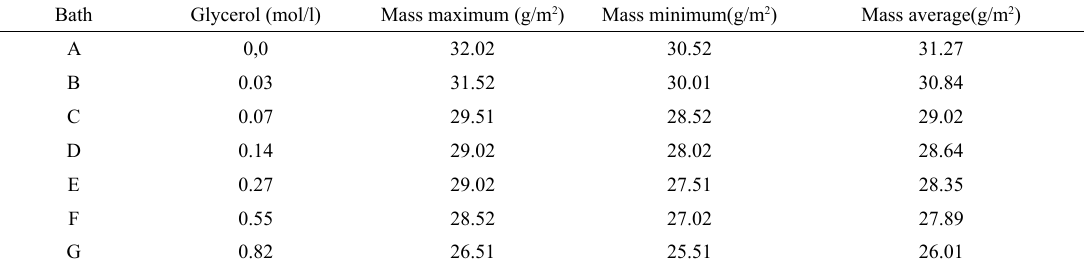
Table 2. Mass of zinc coating per square meter of the substrate (g/m 2 ) obtained from bath deposition containing different concentrations of glycerol.